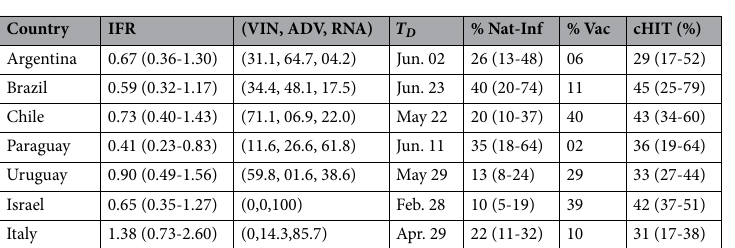
Figure 1. Temporal variation of viral effective reproduction number estimated from daily SARS-CoV-2 ˆ R incidence data ( R t ) and population mobility data ( t ). Background colors indicate the following time periods: in blue, the time period used to fit the linear model (see “Estimation of the viral effective reproduction number and decoupling time” section), in yellow, the period after the fitting, but before the decoupling time, and in red after the decoupling point. The black dot corresponds to the last time the R t was above one. The correlation ˆ R corresponds to the period used to fit the model. The delay indicated is the time-shift between t and R t in order to maximize their correlation in the linear regression.